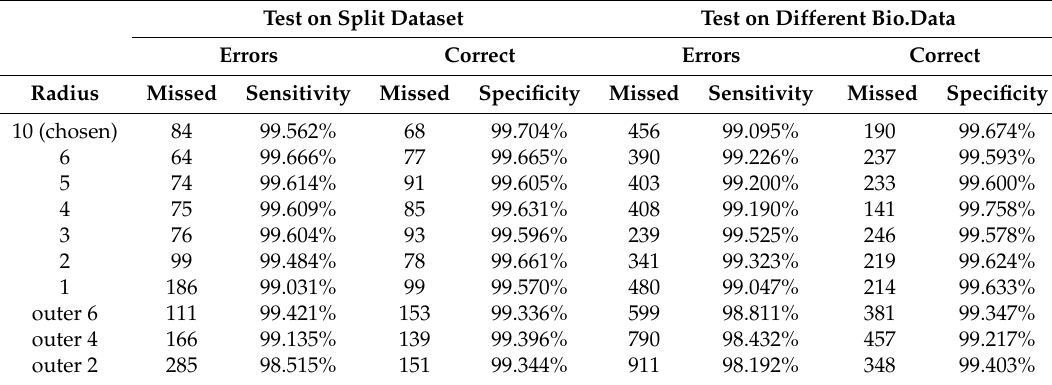
Table 2. Change of accuracy with different ANN input neuron counts.